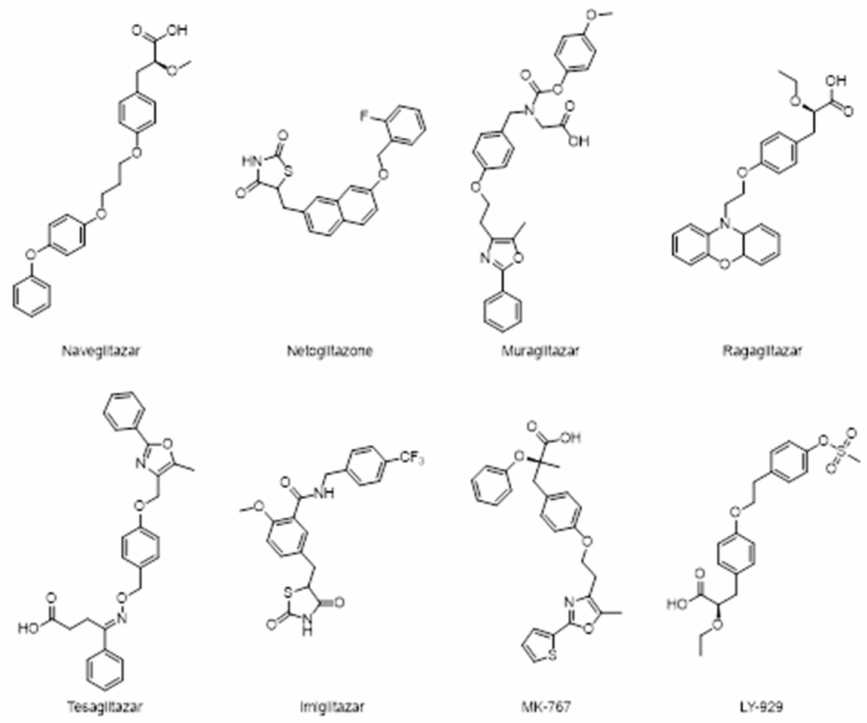
Figure 11. Structures of several peroxisome proliferation activated receptor (PPAR)- α / γ dual